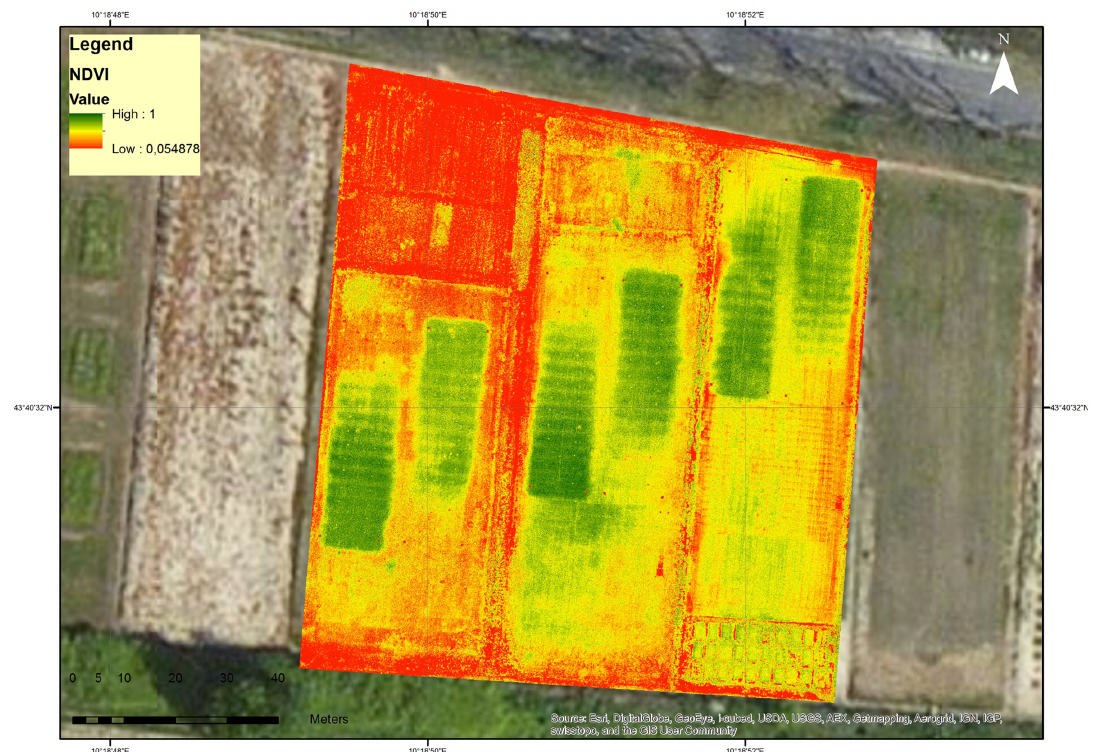
Fig 2. The RGB image of the turfgrass fields acquired by Tetracam ADCMicro mounted on the unmanned aerial vehicle.